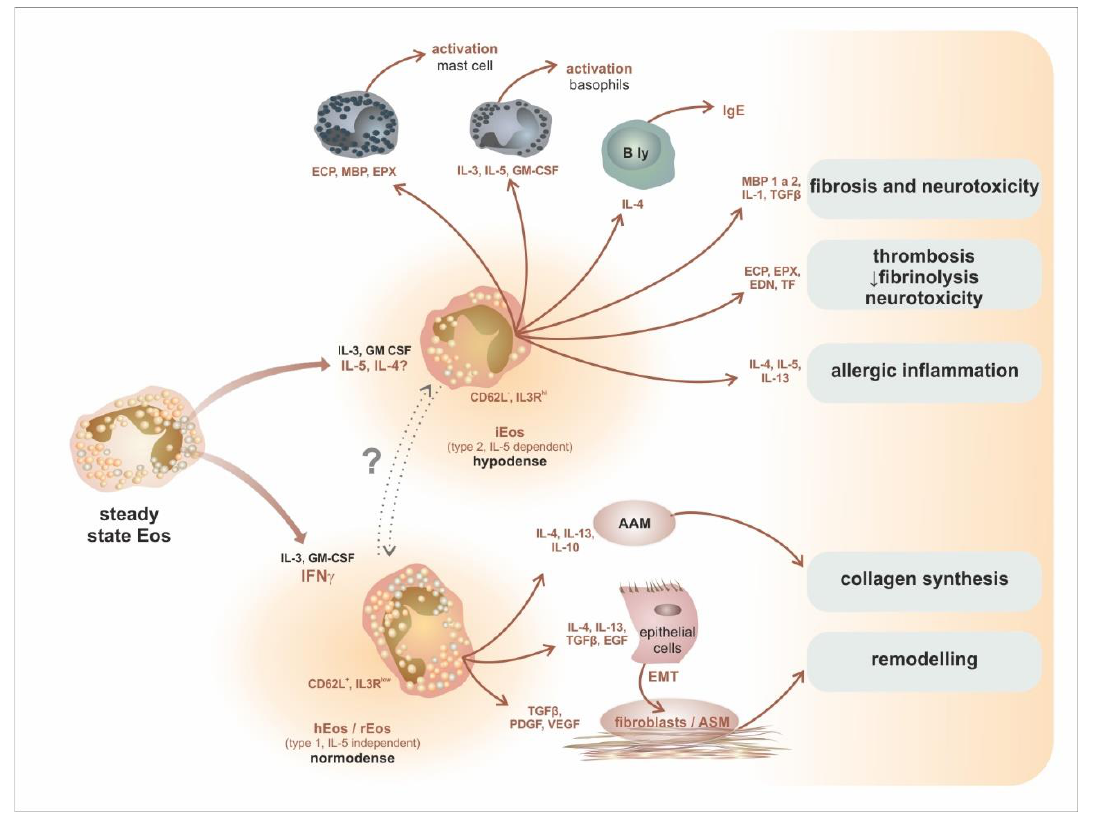
Figure 9. Complex role of eosinophils in the tissue through the prism of their subsets. The current view of eosinophil subsets is in accordance with Abdala Valencia’s concept. Steady-state eosinophils can differentiate into proinflammatory eosinophils (iEos, IL-5-dependent, similar to hypodense eosinophils) and regulatory/homeostatic eosinophils (hEos/rEos, IL-5-independent, similar to nor- modense eosinophils). Both cell types have distinct phenotypes and functional characteristics, leading to different consequences of immune/tissue reactions. iEos are involved in allergic inflammation, the activation of mast cells, basophils, and B-lymphocytes, fibrosis, neurotoxicity, and coagulation. hEos probably stimulates collagen synthesis initiated by AAM and possibly other reparatory pro- cesses, such as remodelling or EMT. Abbreviations: AAM—Alternatively Activated